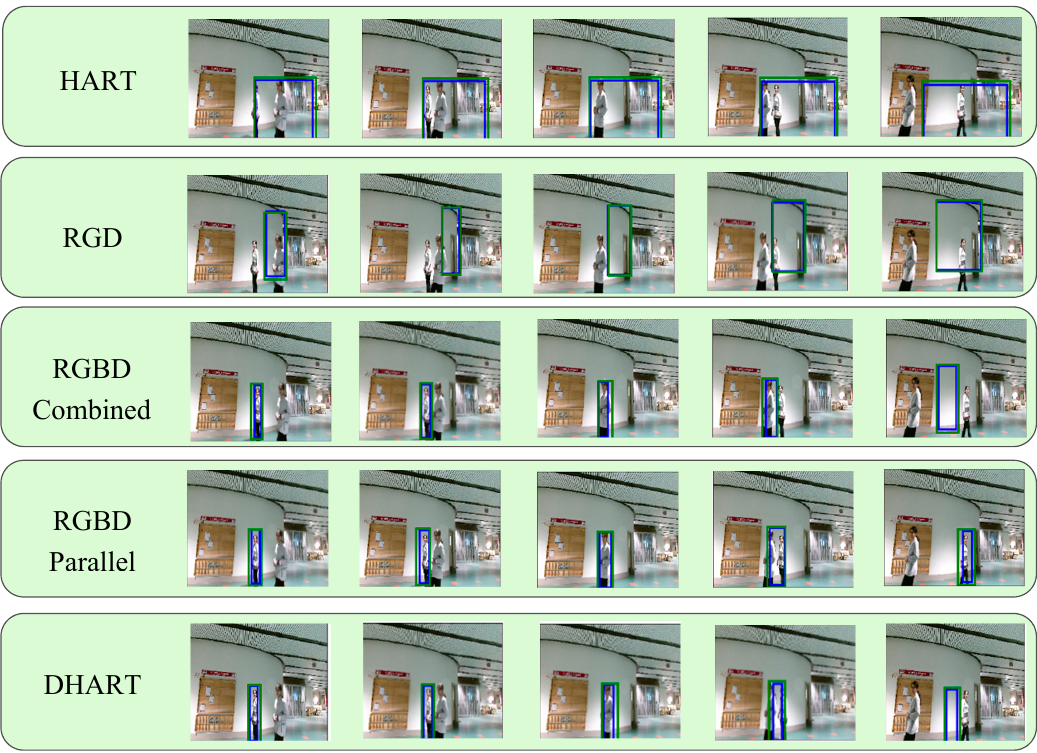
Figure 6. The object tracking model results (blue box—bounding box, green box—attention area): RGB, RGD, RGBD-combined, RGBD-parallel, and depth methods, respectively, from top to bottom.